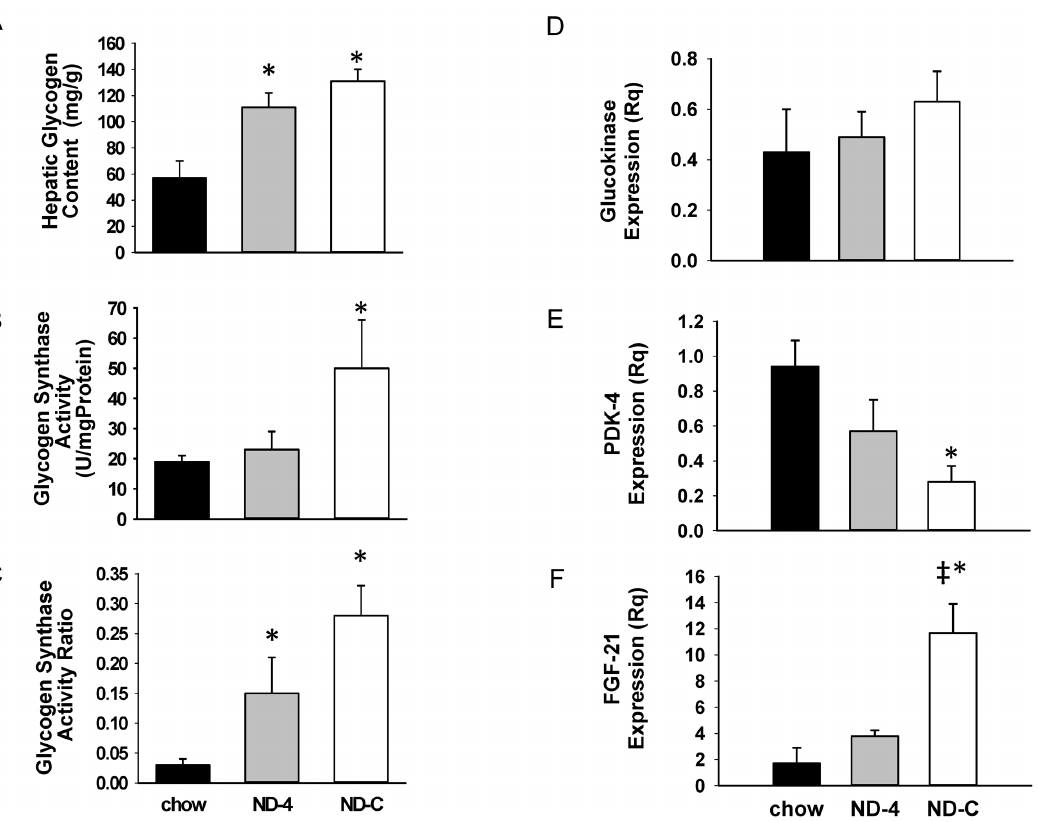
Figure 2. Glycogen content, glycogen synthase activity and activity ratio and the expression of GK, PDK4 and FGF-21 in the liver from chronically catheterized conscious insulin- treated depancreatized dogs that were either on a chow diet or fed isocaloric nutritional support as a constant infusion (ND-C) or once a day for 4 days (ND-4). * and ` indicate significantly different from chow and ND-4, respectively (p ,